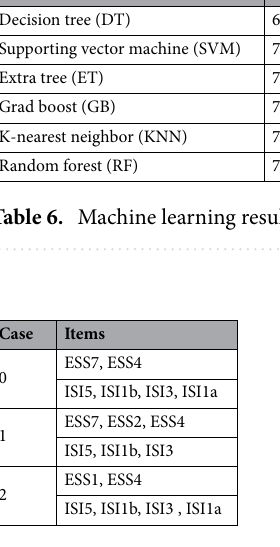
Table 7. Case with 6 ISI/ESS